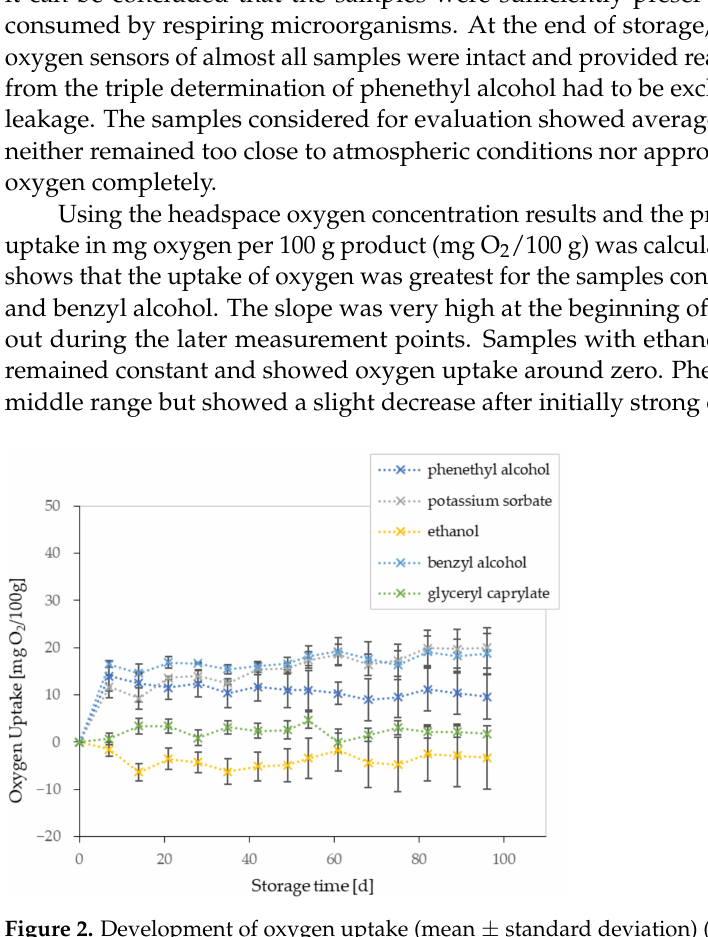
Figure 2. Development of oxygen uptake (mean ± standard deviation) (mg O 2 /100 g) with different preservatives, calculated from the oxygen concentration in the headspace measured over a storage time of 96 days at 30 ◦ C under light